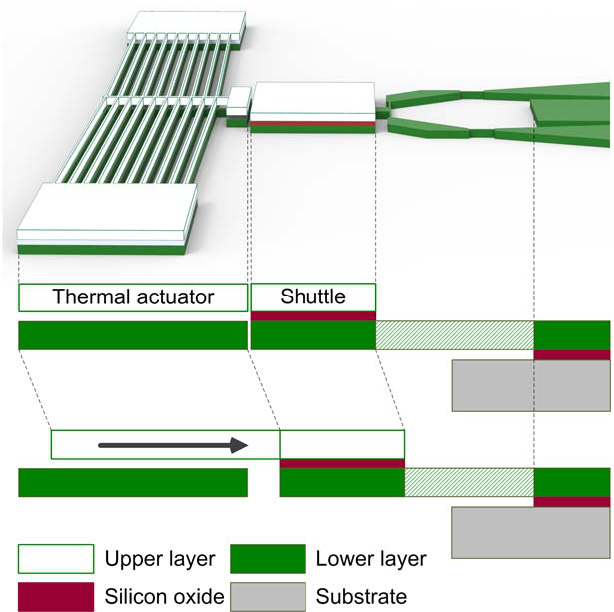
Figure 4. Electrical isolation design to avoid short circuit formation and charge leakage between the chevron thermal actuator and the electrostatic actuator.